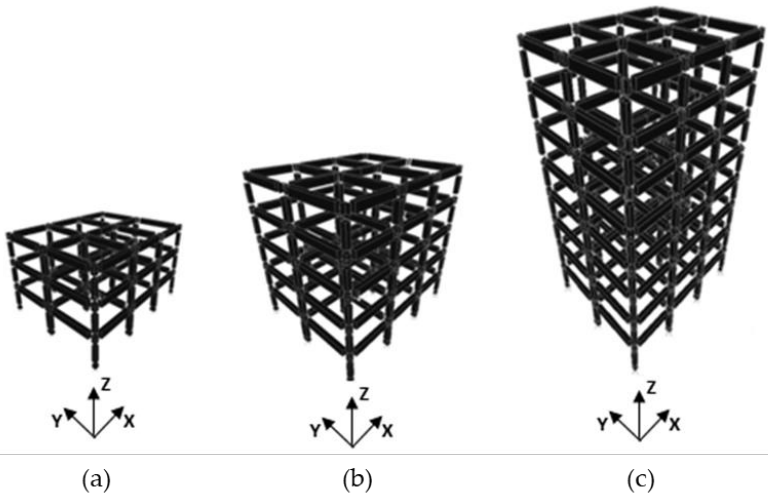
Figure 2. Numerical models of structures that are regular in plan: ( a ) 3 floors, ( b ) 5 floors, ( c ) 8 floors.